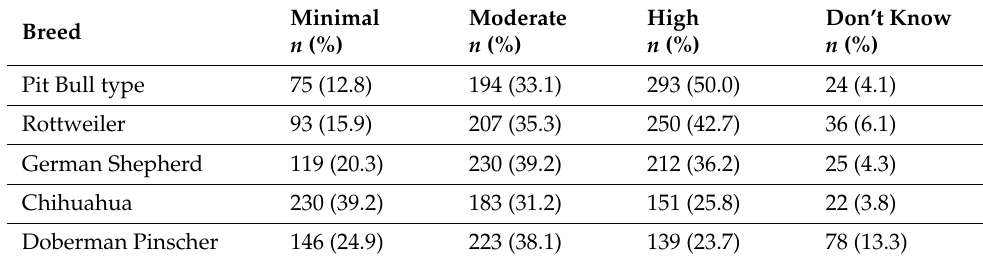
Table 3. Serious Bite Risk Perception of Common Dog Breeds in the United States.